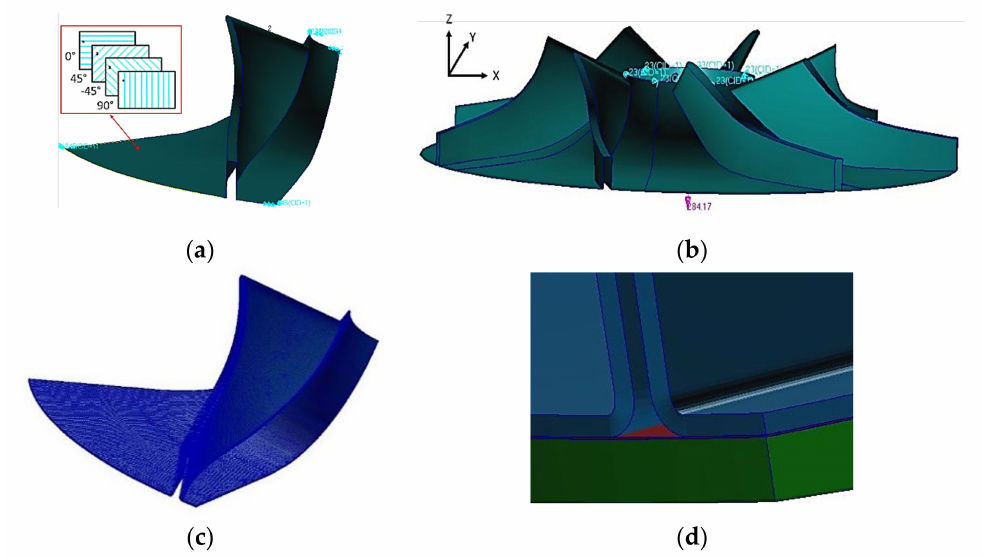
Figure 4. Boundary conditions for 2D shell element of the ( a ) blade sector with composite lay-up and ( b ) impeller blading; and for 3D element of ( c ) disc and blading element and ( d ) interface location in